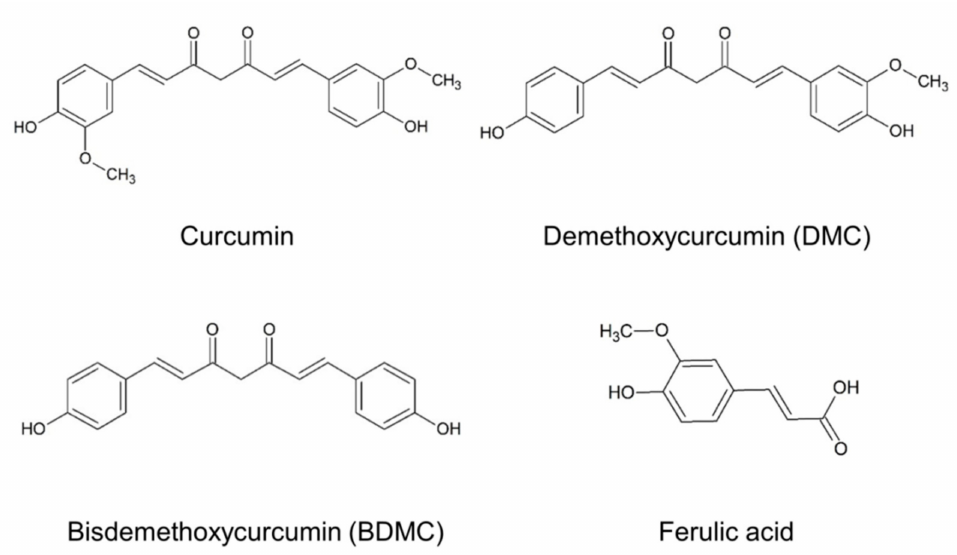
Figure 1. The chemical structures of curcumin, demethoxycurcumin (DMC), bisdemethoxycurcumin (BDMC), and ferulic